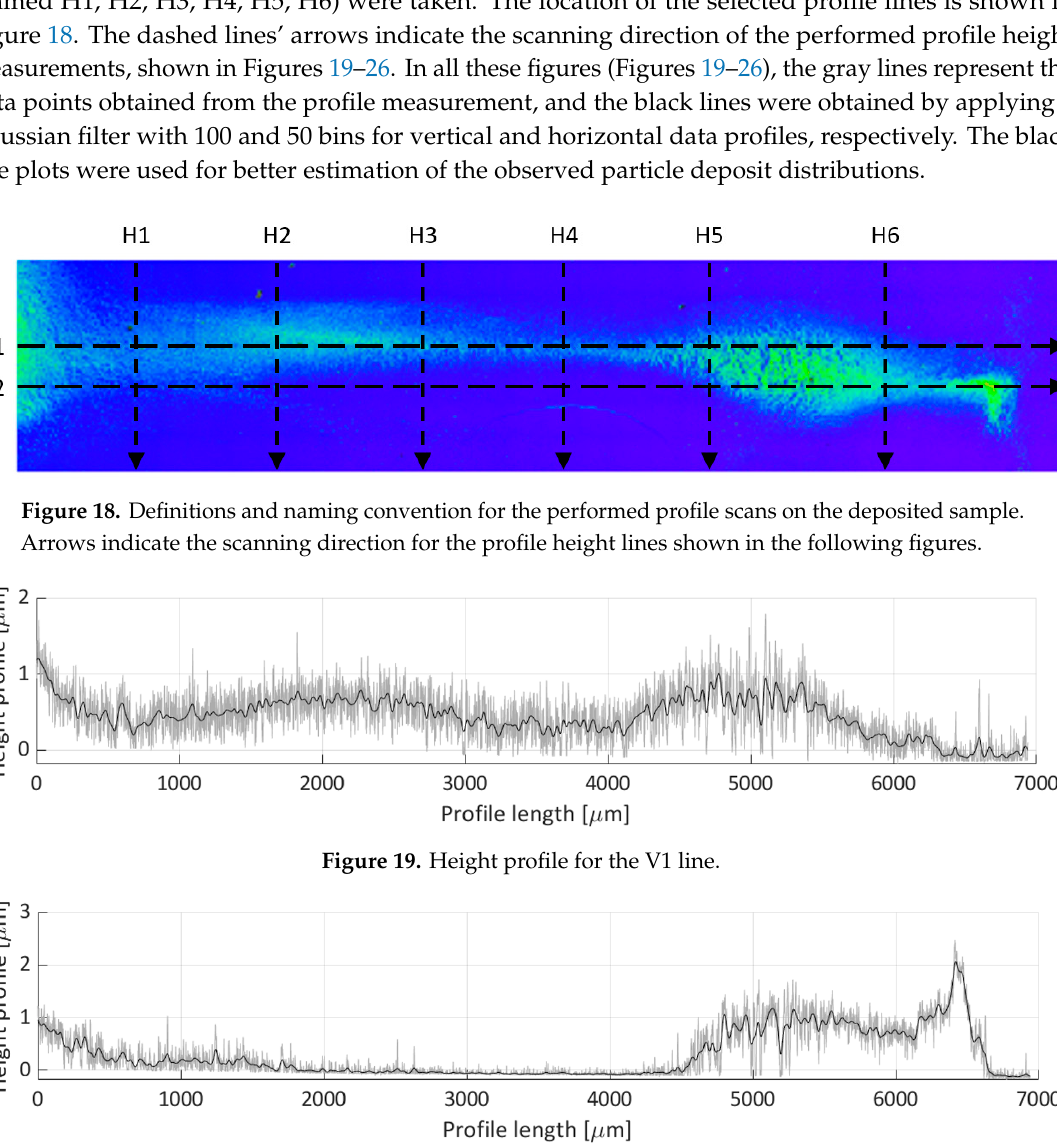
Figure 20. Height profile for the V2 line.